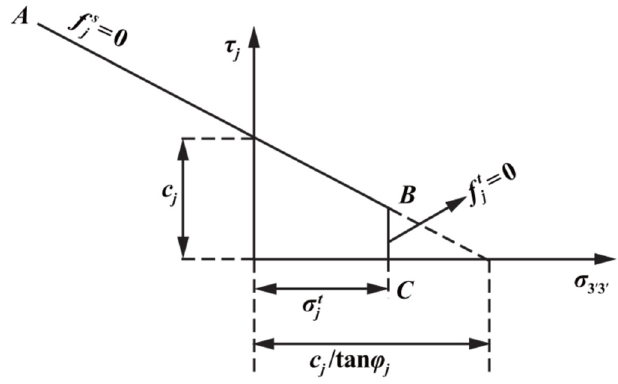
Figure 5. Weak plane failure criterion.